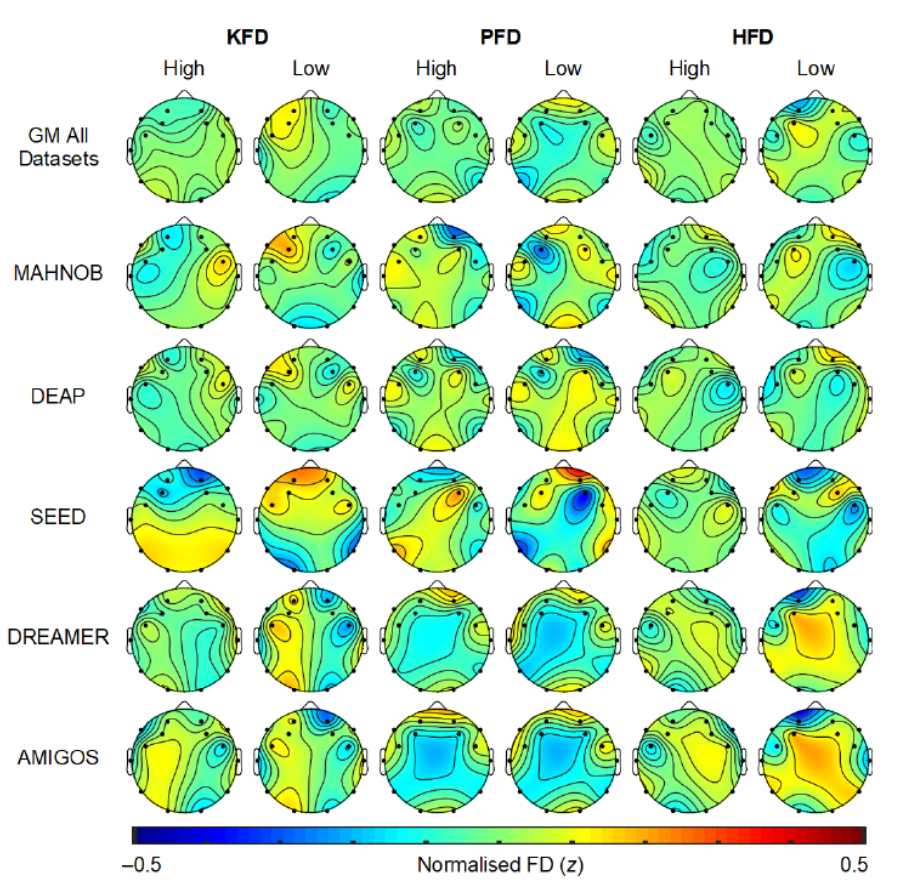
Figure 4. Topography of normalized EEG FD features for high/low valence. GM denotes the grand mean of each FD feature across all the datasets. KFD—Katz’s fractal dimension, PFD—Petrosian fractal dimension, HFD—Higuchi’s fractal